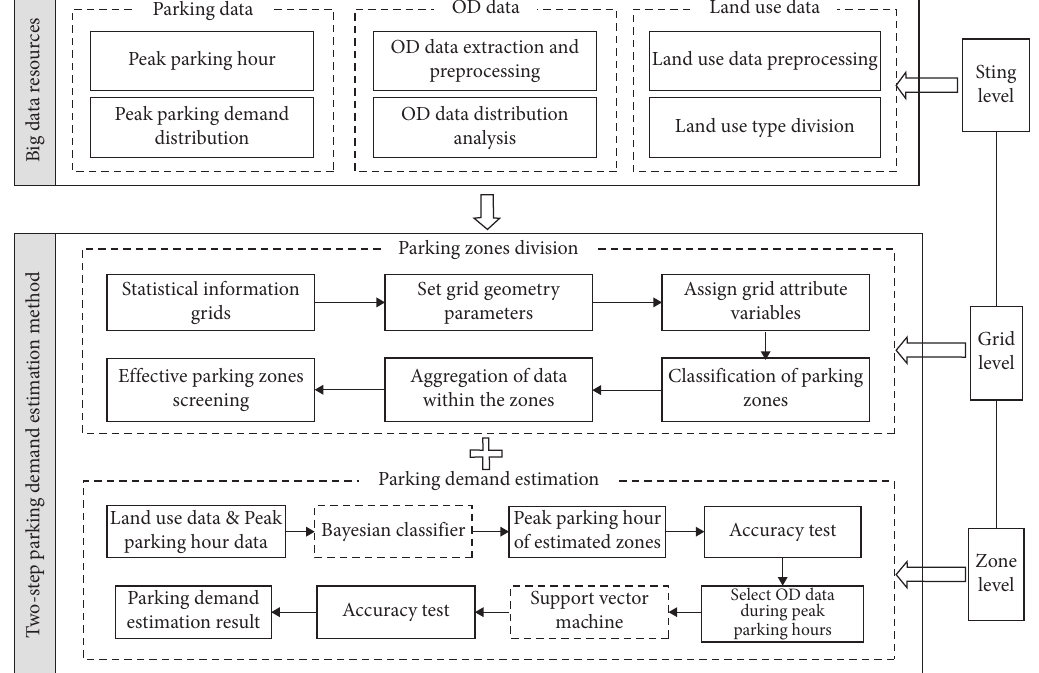
Figure 3: Methodology framework adopted to resolve the parking demand estimation problem.